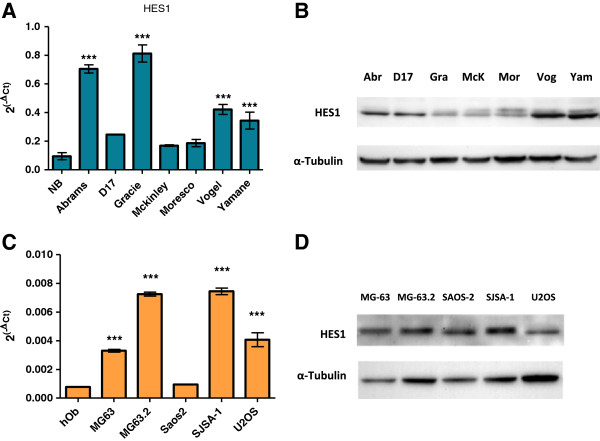
Expression of HES1 mRNA and protein in human osteosarcoma cell lines.HES1 mRNA in canine OSA cell lines and normal canine bone tissue (NB) expressed as 2(-ΔCT) normalized to HPRT1 (A). HES1 mRNA in human OSA cell lines and normal human osteoblasts expressed as 2(-ΔCT) normalized to the geometric mean of RBS15, GAPDH, 18SrRNA, and HPRT1 (C). Data are graphed as mean ± SEM, *** P < 0.001, ** P < 0.01, Two-way ANOVA with Dunnett’s Multiple Comparison Test. (B and D) Western blot shows characteristic distinct HES1 band at 30 kDa. Blot was stripped and re-probed with an antibody against α-tubulin to serve as a protein loading control.